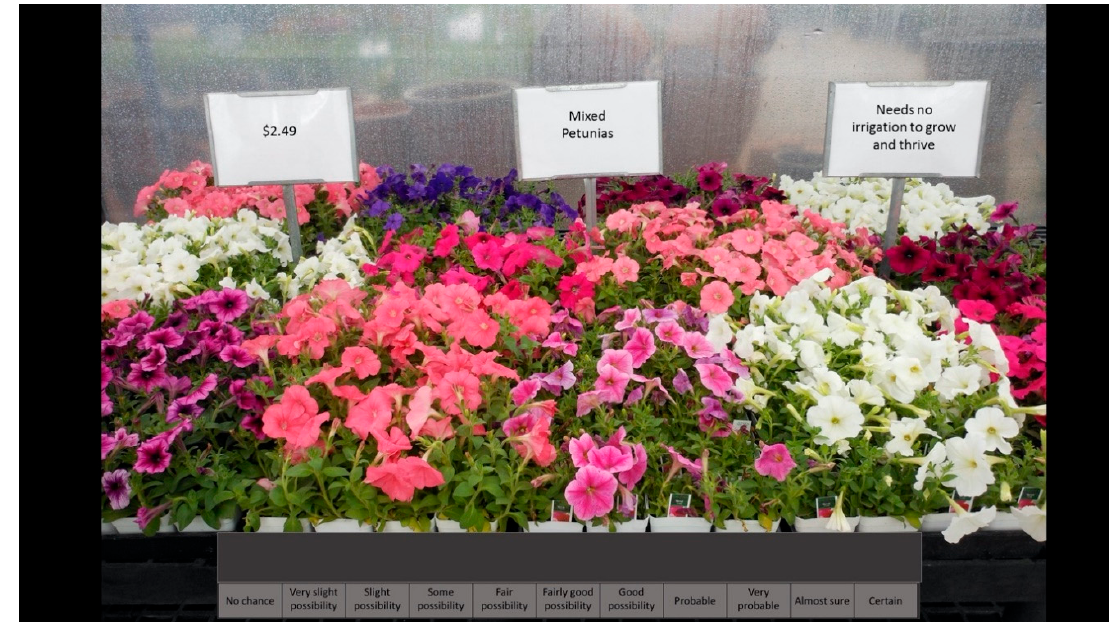
Figure 1. Example of the simulated retail merchandising display that was projected on a computer screen that subjects viewed with the attribute levels: annual plants, regular price, no plant guarantee, and needs no irrigation; 11-point Juster scale on the bottom.